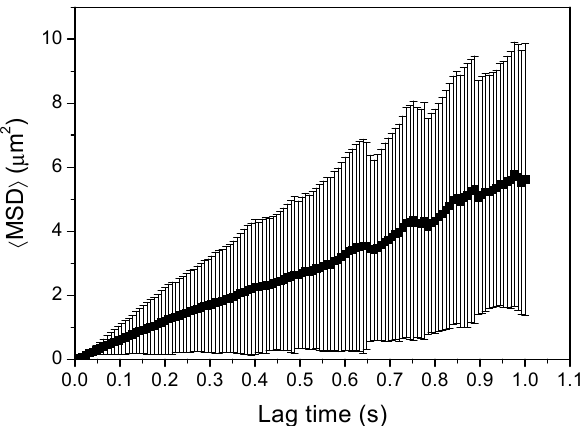
Figure 2. MSD estimation as a function of lag time. The statistical error of the estimation (vertical bars) increases as lag time rises.